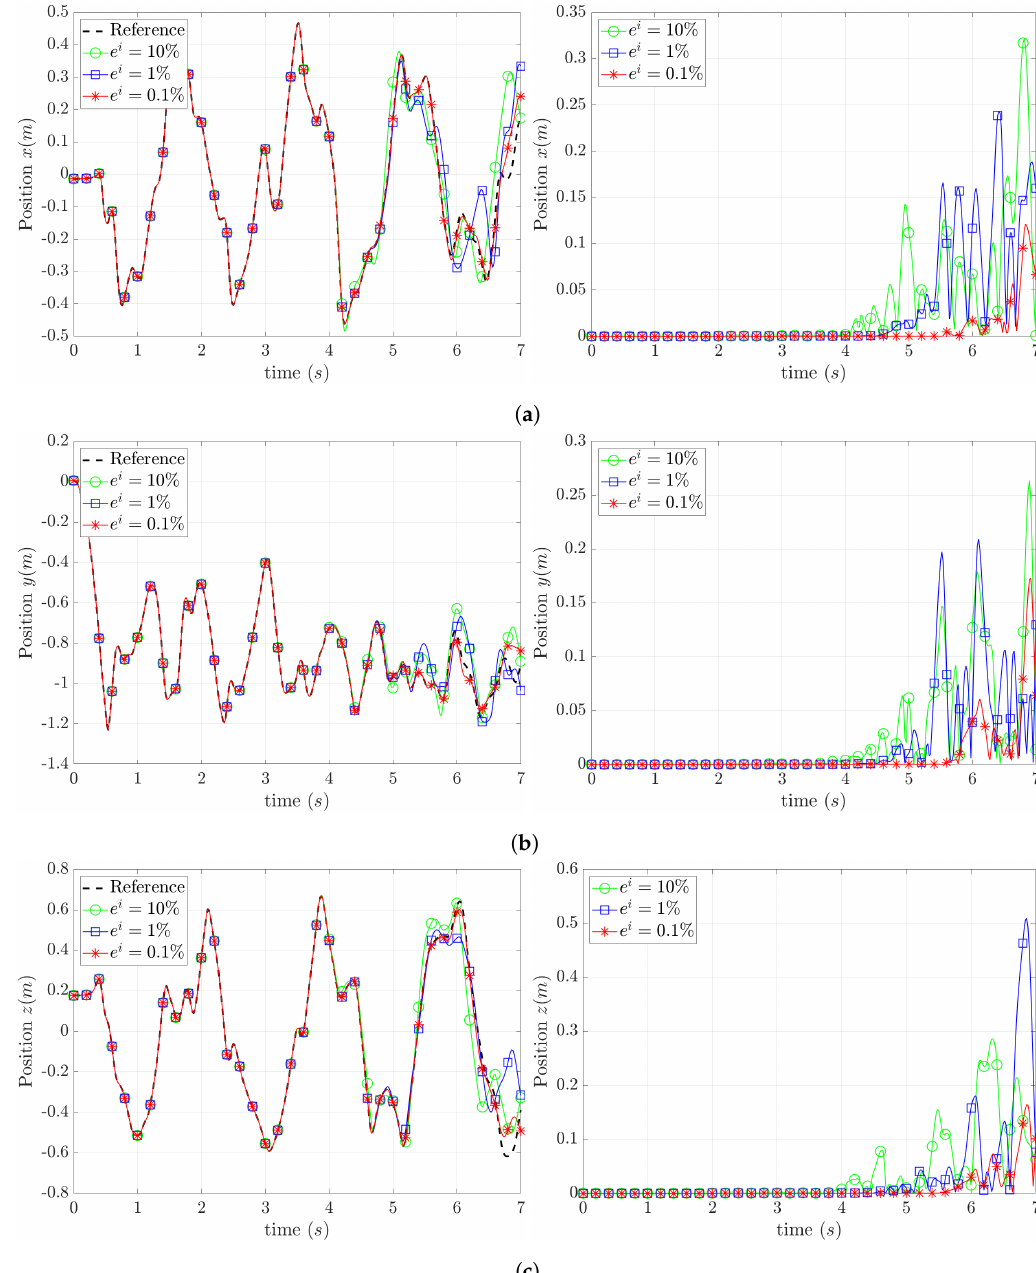
Figure 5. The x , y , and z positions of node A and their absolute error for the error tolerance e i = 10%,1%, and 0.1%. ( a ) Position x of node A and its absolute error; ( b ) position y of node A and its absolute error; ( c ) position z of node A and its absolute